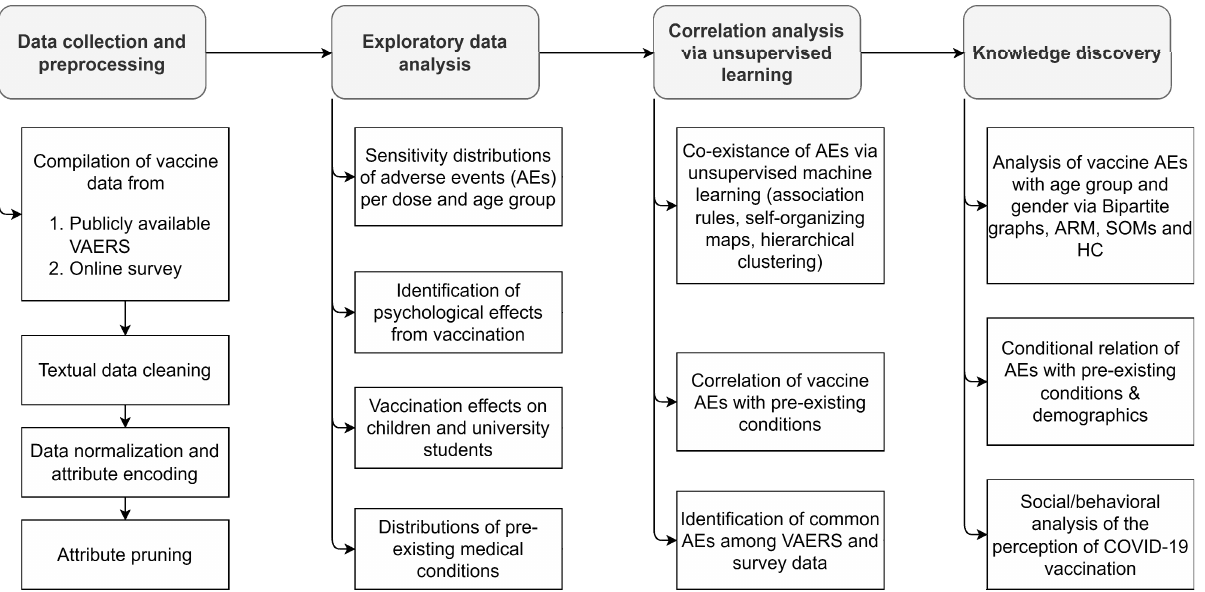
Figure 6. Workflow for the analysis of psychological and physical effects of COVID-19 vaccines on populations based on various demographics.